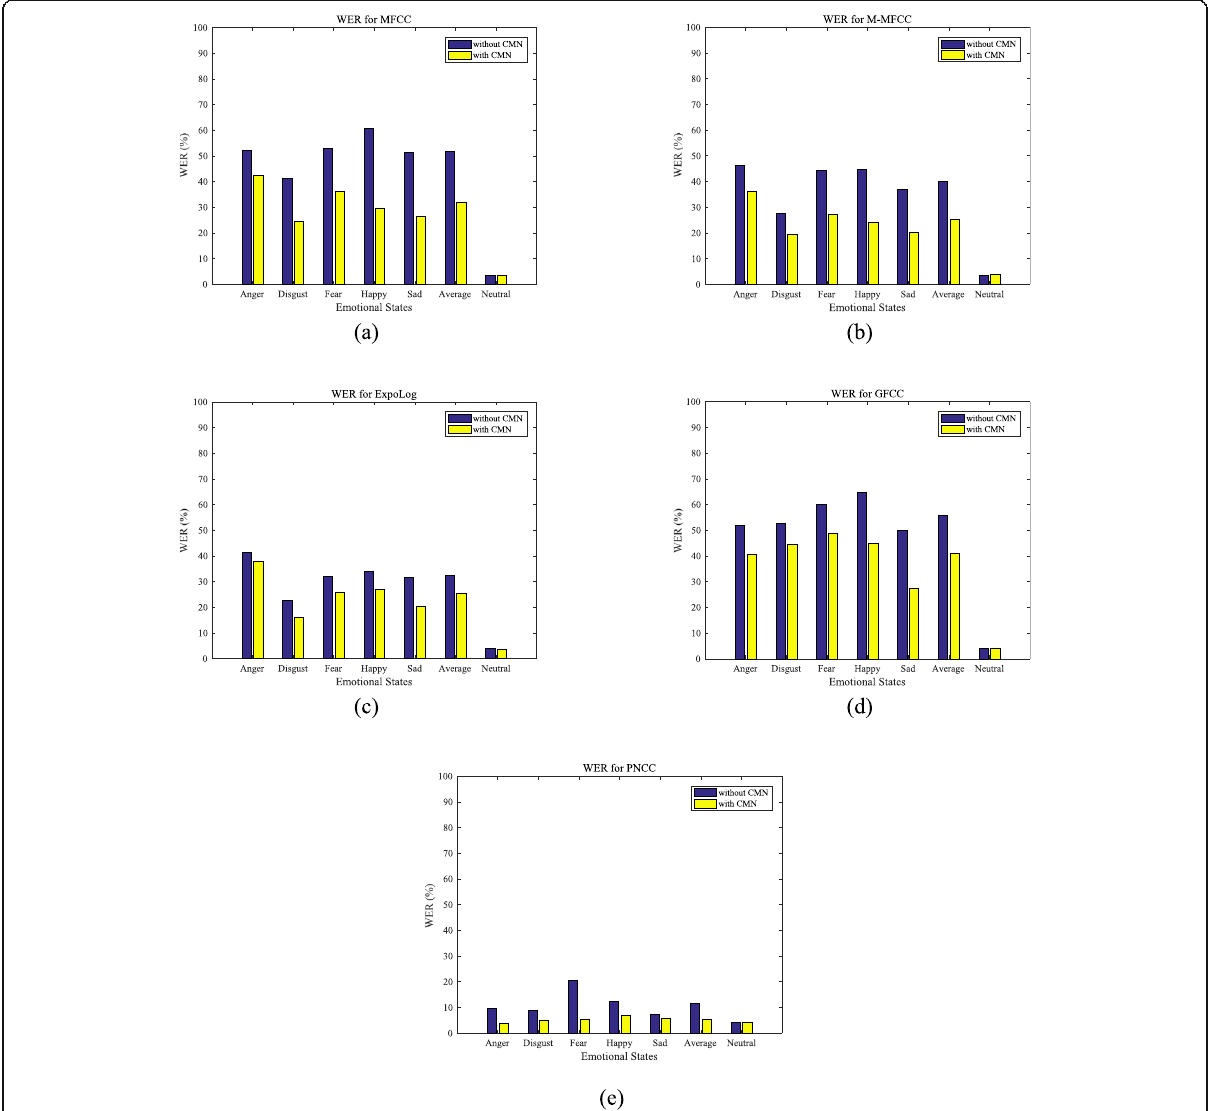
Fig. 6 WER scores (%) for the Persian ESD dataset with/without applying the CMN method to the acoustic features of a MFCC, b M-MFCC, c ExpoLog, d GFCC, and e